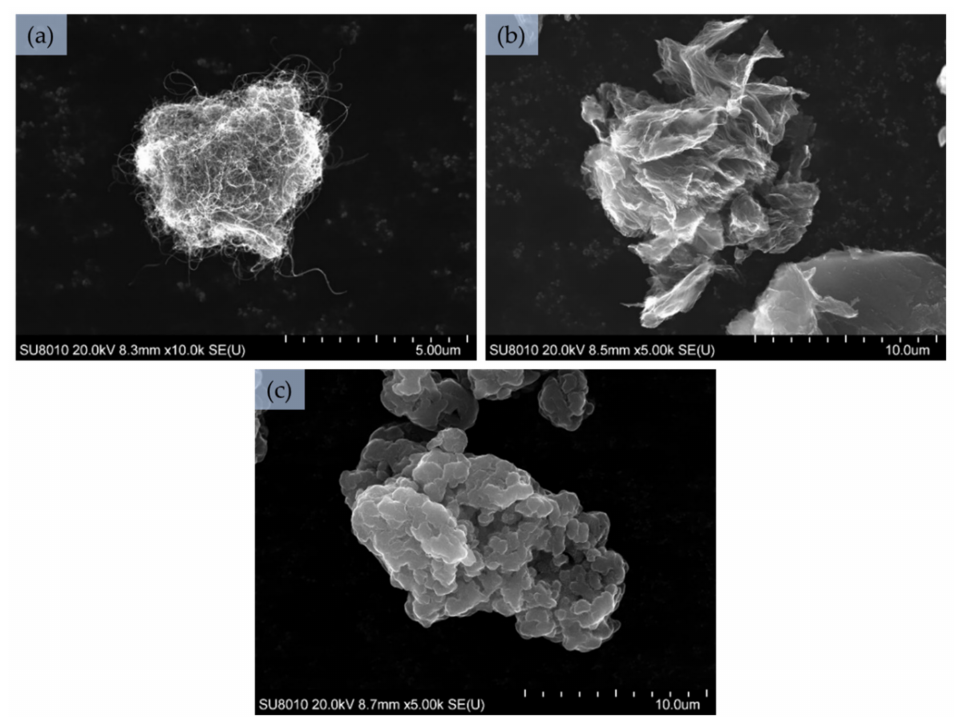
Figure 1. SEM images of pristine additives: ( a ) MWCNs, ( b ) rGO, ( c ) PANi.